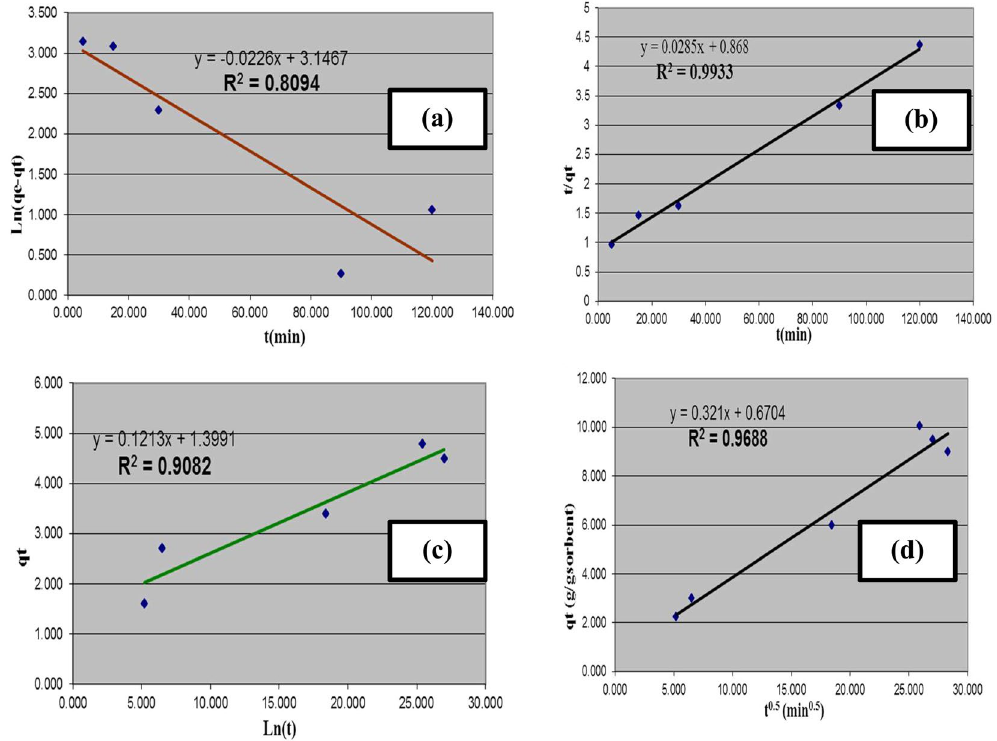
Figure 9. Kinetics of oil sorption process onto nano-magnetic activated carbon material: ( a ) Pseudo- first- order, ( b ) Pseudo- second-order, ( c ) Simple Elovich, ( d ) Intraparticle diffusion.